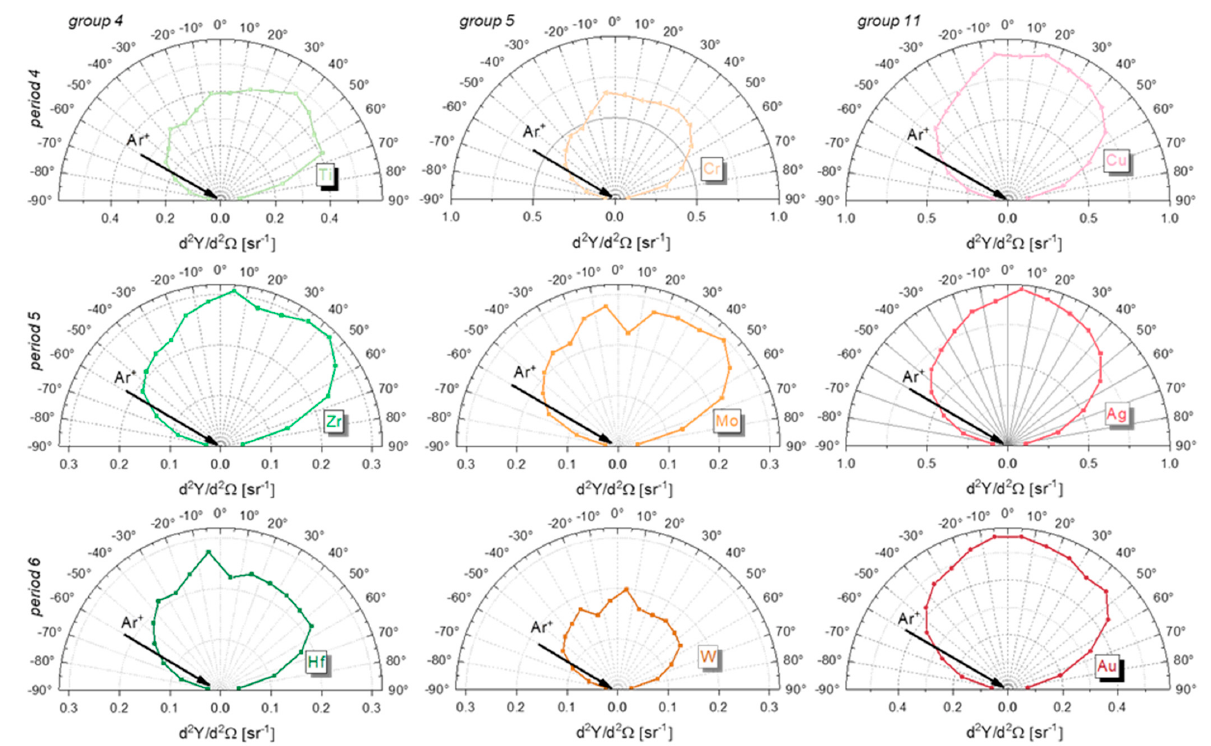
Figure 8. Angular distribution of sputtered atoms for selected elements (Ti, Cr, and Cu; Nb, Mo, and Ag; Hf, W, and Au) bombarded by argon ions at 60° angle and energy of 600 eV.